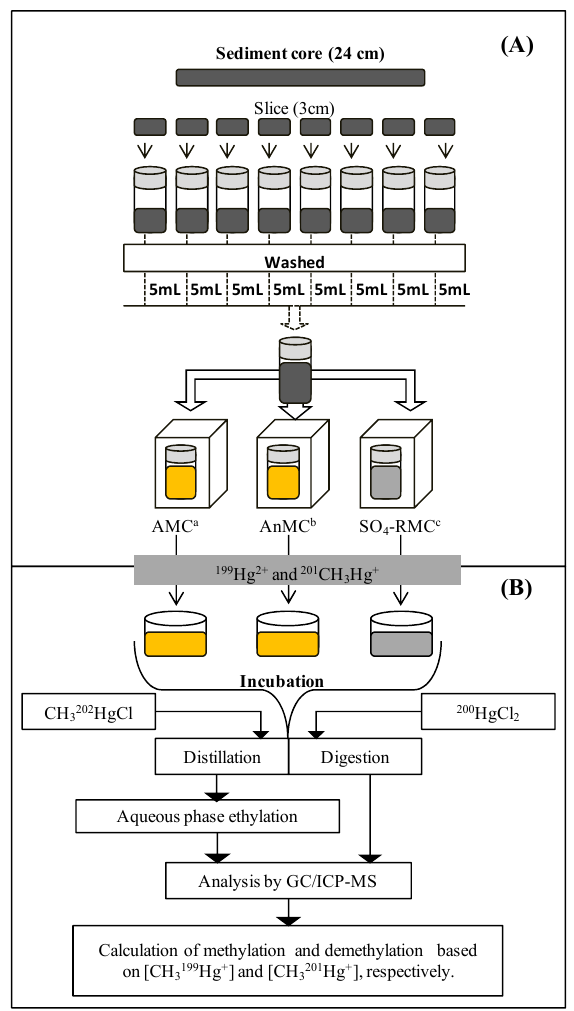
Figure 1. Illustration of the process for the isolation of microbial communities ( A ) and subsequent incubation with isotope ‐ enriched Hg species to evaluate microbial potential to methylate and demethylate mercury ( B ). CH 3201 Hg degradation and CH 3199 Hg production were monitored using gas chromatography and inductively coupled plasma mass spectrometry (GC/ICP ‐ MS) analysis.